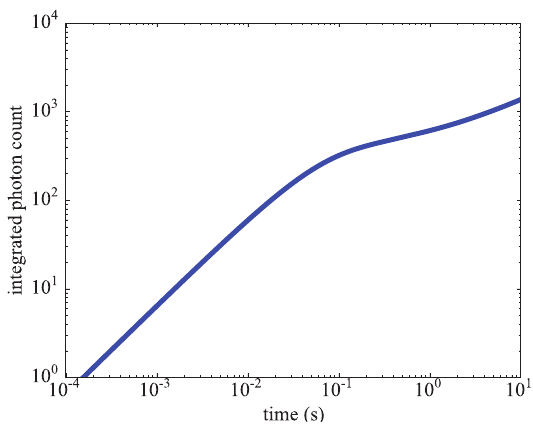
Figure 9. The total number of photon scatters from | b0 + , v = 0, J = 0 (cid:105) as a function of time, in the two-laser fluorescence state detection scheme described in the